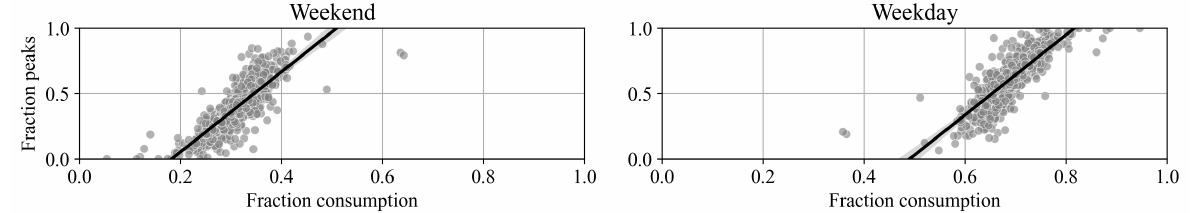
Figure 15. Relation between the fraction of consumption and peak demands in the time periods at the weekly level, with an OLS regression estimate overlaid.